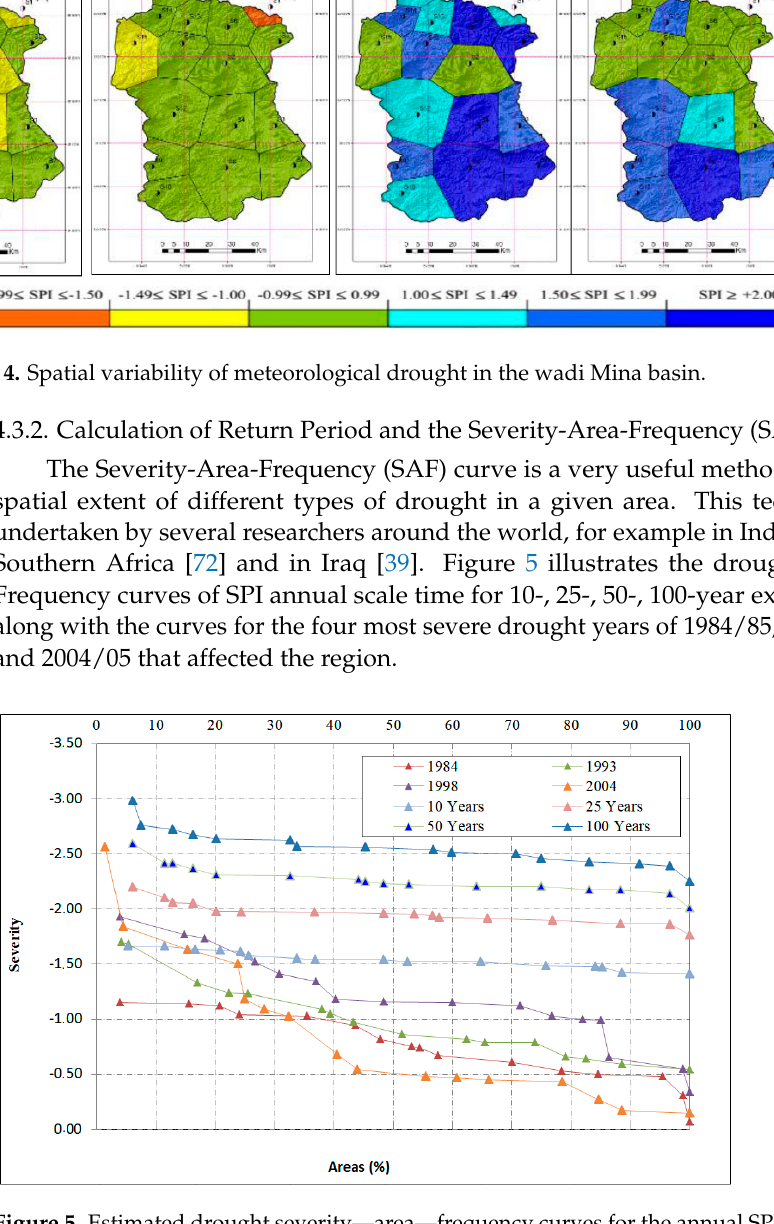
Figure 5. Estimated drought severity—area—frequency curves for the annual SPI values for the Wadi Mina basin, as compared those seen in historical droughts.